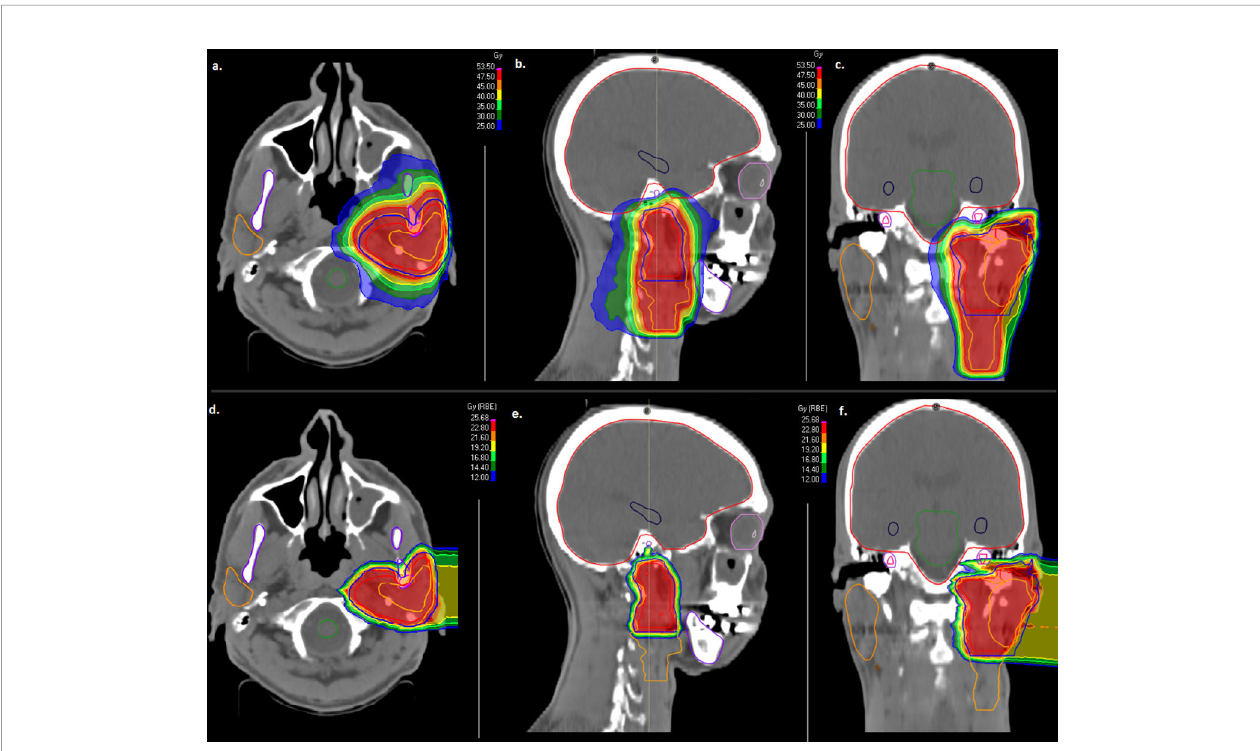
FIGURE 1 | Combined treatment plan with intensity modulated radiotherapy (IMRT, A – C ) and active raster-scanned carbon ion radiotherapy (CIRT, D – F ) of a patient with a pT3pN0 (0/34) ACC of the left parotid gland. CTV2 involved the left parotid space and the left cervical lymphatic drainage (A – C) and CTV1 involved the left parotid space only (D – F) . IMRT was applied with 50 Gy in 2 Gy fractions (A – C) and CIRT was applied with two beams up to 24 Gy (RBE) in 3 Gy (RBE) fractions (D – F) . From left to right, axial dose distribution, sagittal dose distribution and coronal dose distribution are